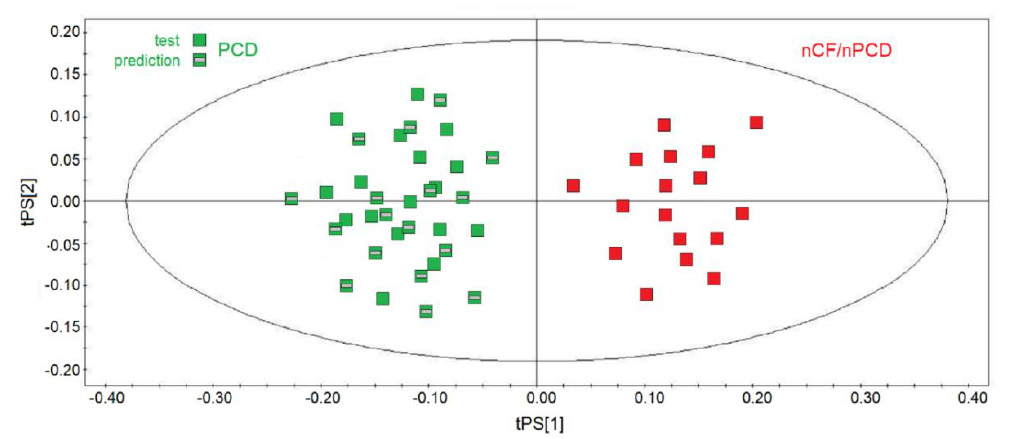
Figure 9. Predictive scores plot of the validation PCD set of samples. nCF / nPCD and PCD samples of the training sets are indicated by red squares and green squares, respectively, while green squares with a gray bar in the middle represent the 17-sample prediction set. The position of each sample is identified by the associated predictive coordinates